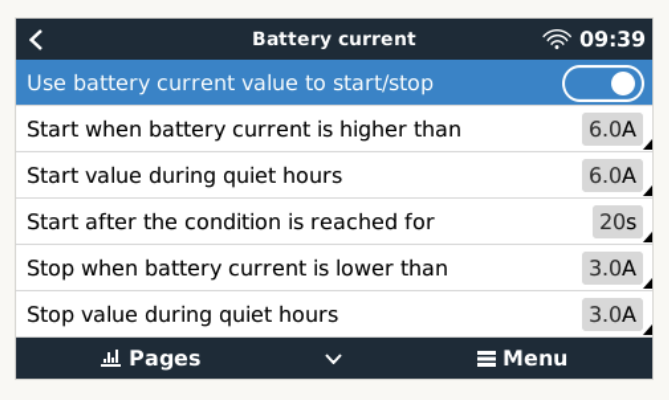
Figure 16. Condition configuration based on voltage.